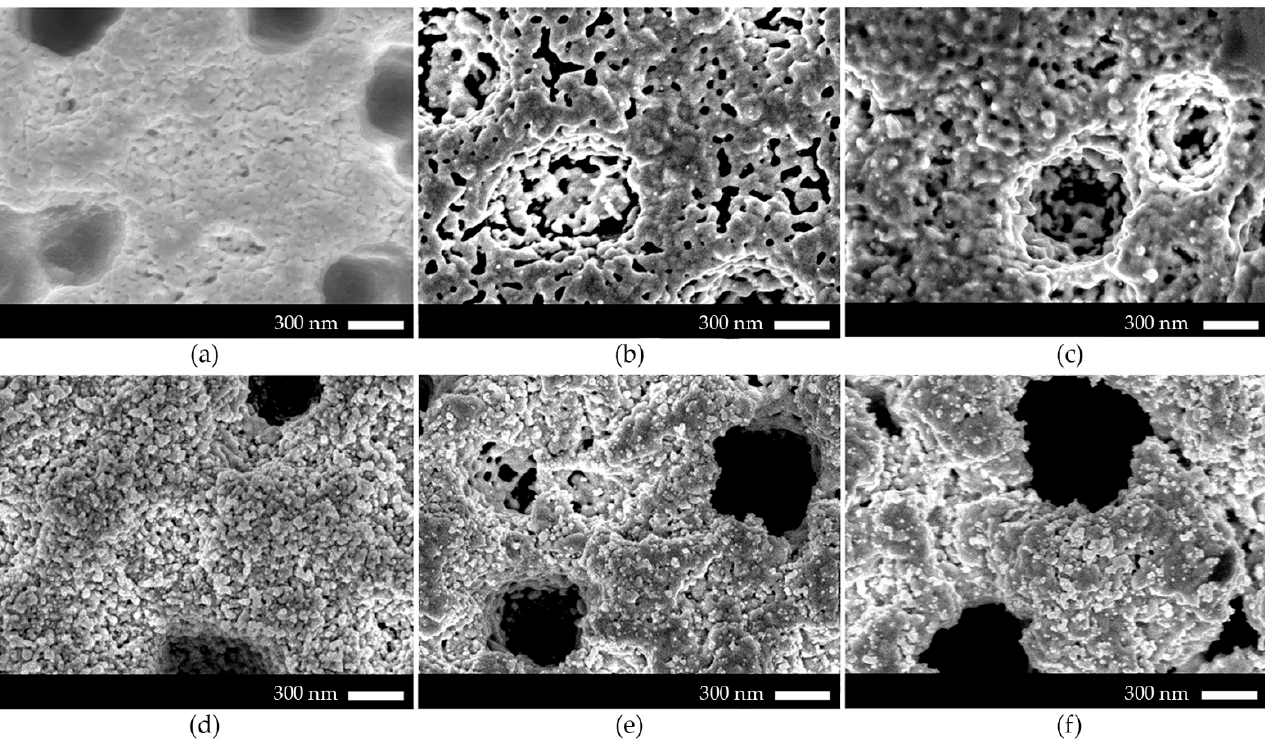
Figure 7. Mean Au NP diameter as a function of the gold deposition time on the macro-PS. Figure 8 shows the XRD pattern for the Au-coated macro-PS after 50 min and 80 min of Au deposition. The patterns reported peaks associated with (111), (200), (220), and (311) Au crystal orientations, confirming the polycrystalline nature of the samples. Interest- ingly, in contrast to the XRD patterns for the Au-coated meso-PS (Figure 4a,b), no charac- teristic Si peak was observed in the XRD pattern for the gold-coated macro-PS, as shown in Figure 8a. This confirmed the introduced mechanism of Au film growth, where the coverage became uniform after the complete dissolution of the micro-PS layer. Apart from that, no noticeable difference between the Au-coated meso- and macro-PS samples was observed from the XRD; compare Figures 8b and 4a,b.